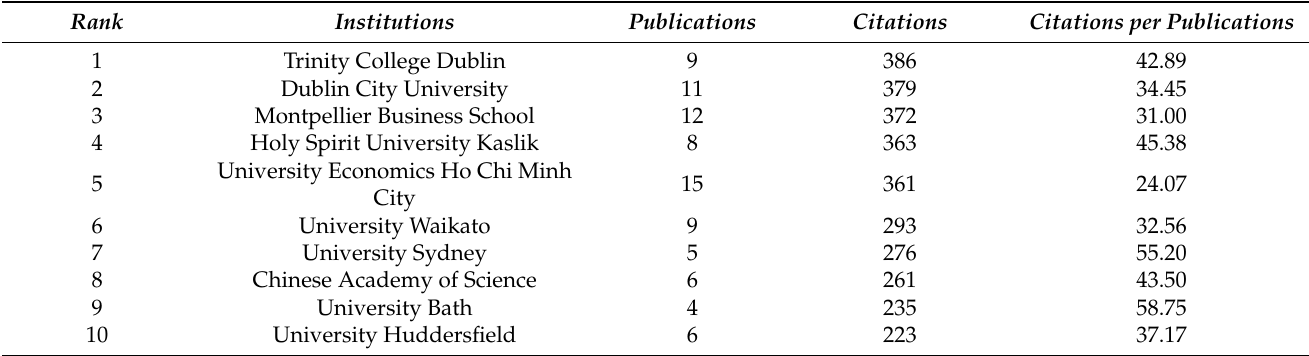
Table 3. Top 10 institutions by number of citations.